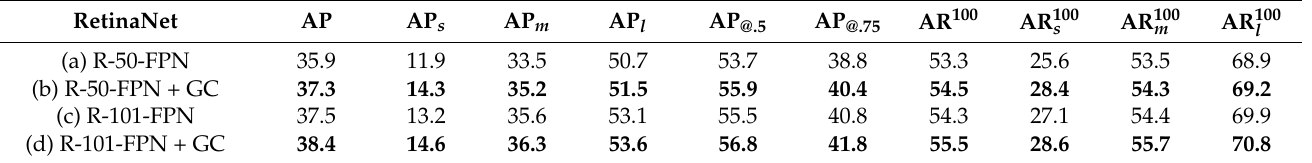
Table 2. Object detection results using RetinaNet [21] on the COCO val2017 dataset. Here ResNet is abbreviated as “R”. Note that RetinaNet uses FPN [15] with a backbone network by default. Incorporating global contexts (GC) improves the quality of object detection in all metrics. The number in bold means superiority compared to that of the baseline in the